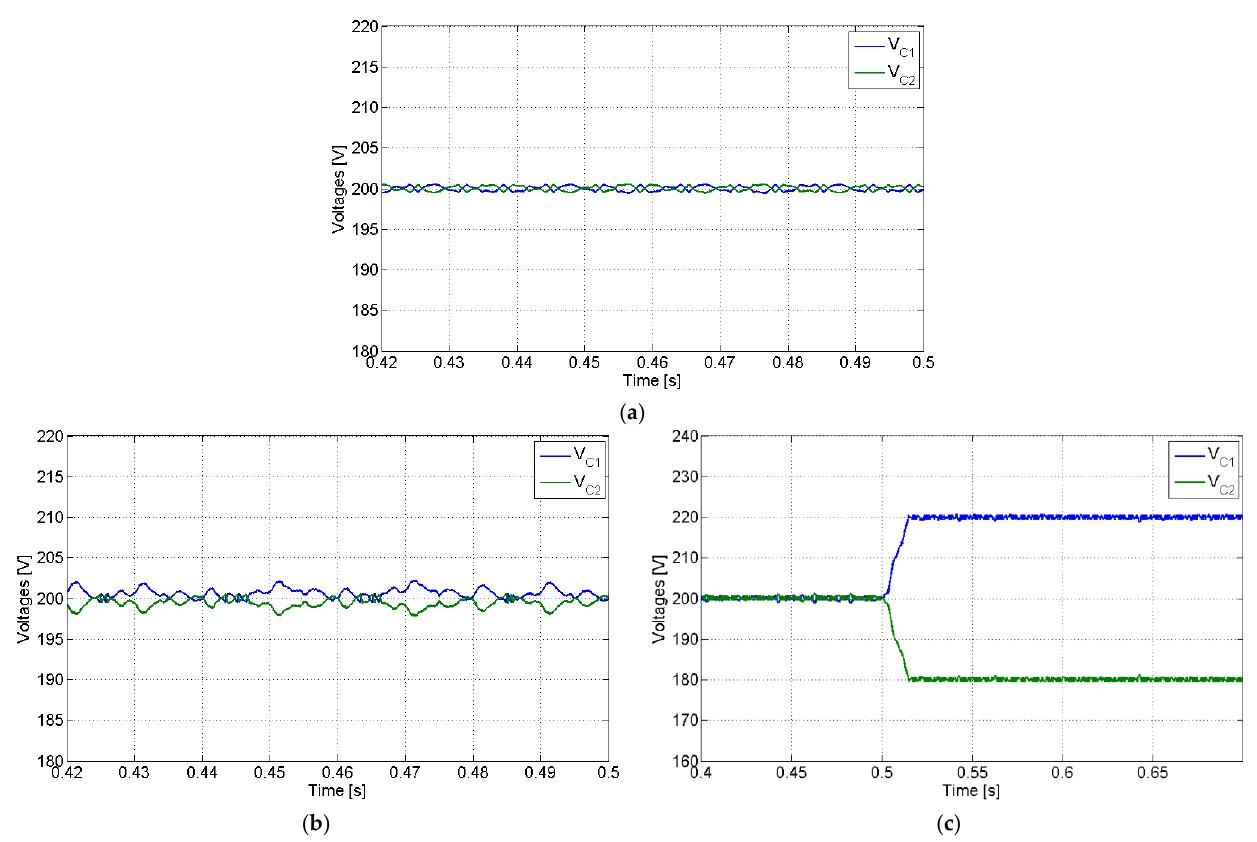
Figure 13. Simulation results with the PV generator in full compensation mode with a linear load and compensation of the active power imbalance: ( a ) voltages in the DC capacitors of the inverter with the same irradiance for the PV panels; ( b ) voltages in the DC capacitors of the inverter with different irradiance in the PV panels; ( c ) voltages in the DC capacitors of the inverter with a change in the reference of the capacitor voltages.